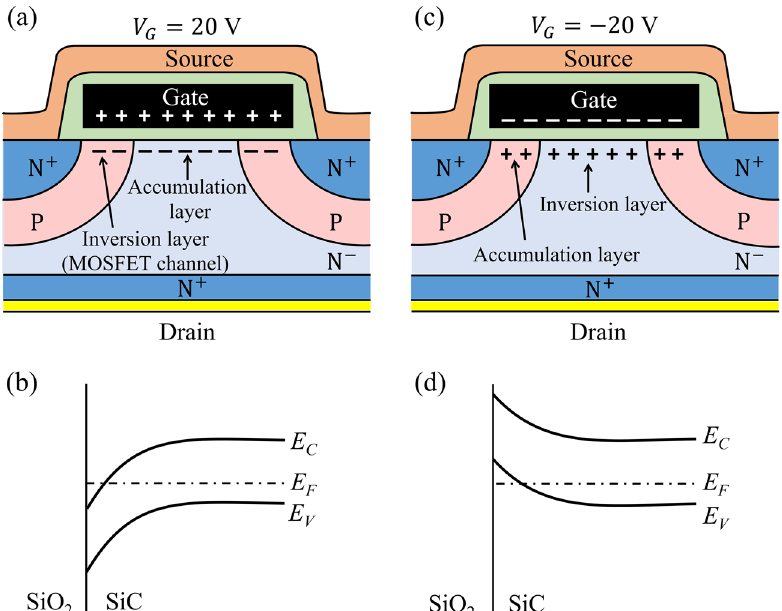
Figure 3. ( a ) Schematic cross-section of a planar power MOSFET, also called VDMOSFET, biased at V G = 20V; ( b ) Energy-band diagram showing that the Fermi level is inside the conduction band for region A; ( c ) Schematic cross-section of the planar power MOSFET biased at V G = − 20V; ( d ) Energy-band diagram showing that the Fermi level is inside the valance band for region